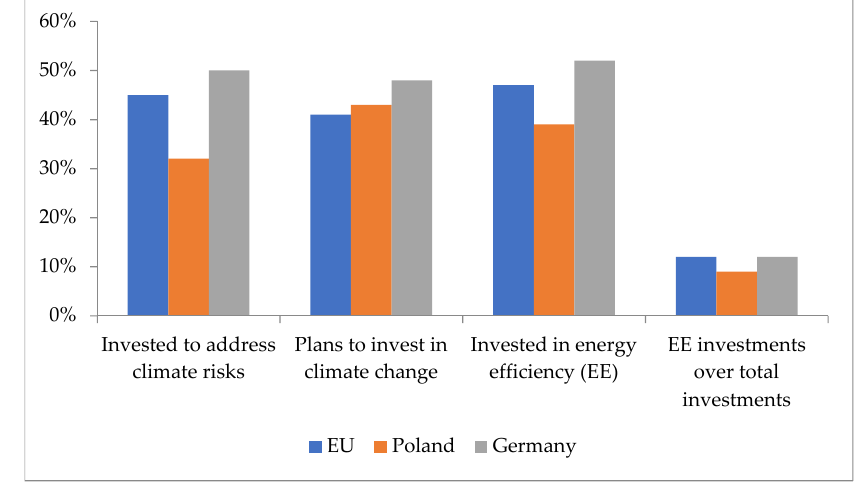
Figure 8. Investment opinion.